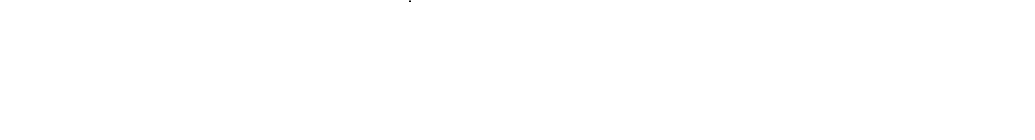
Logopediese Vereniging, Vol. 17, Nr. 1: Des.